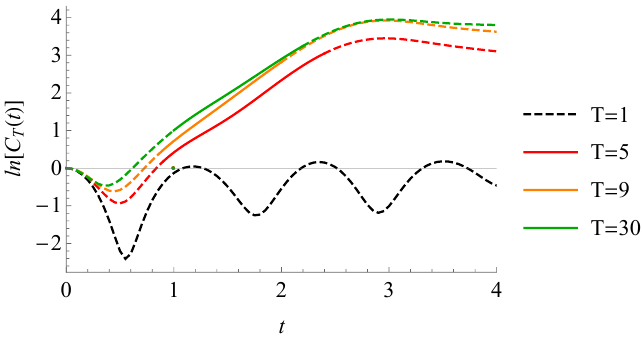
Figure 3 . The time dependence of the thermal OTOCs of the system (2.2) for various values of the temperature T . The dashed part is non-linear and the solid part is linear (exponential in t ). The time domains for the solid lines are determined at each temperature data such that the linear fit provides the smallest confidence interval of the slope normalized by the slope itself. The obtained time domains are longer than the twice of O (1 /λ OTOC ) , which certifies the exponential growth here.